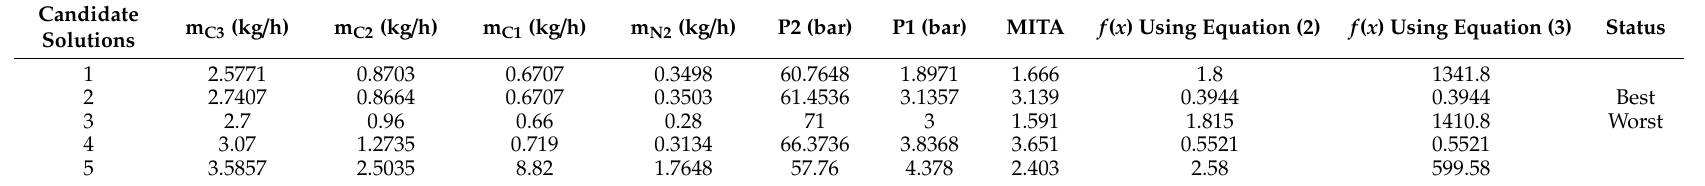
Table 8. Updated candidate solutions for the SMR process after comparing Tables 5 and 6 (first iteration completed).